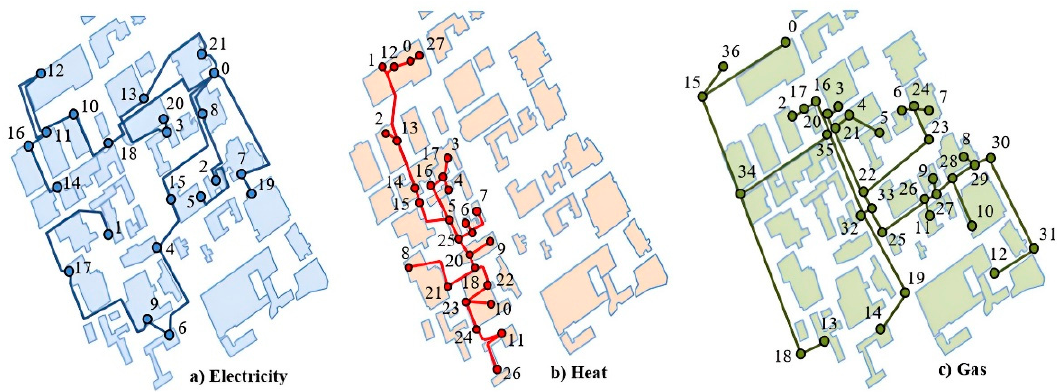
Figure 15. The UoM MED test case [33].